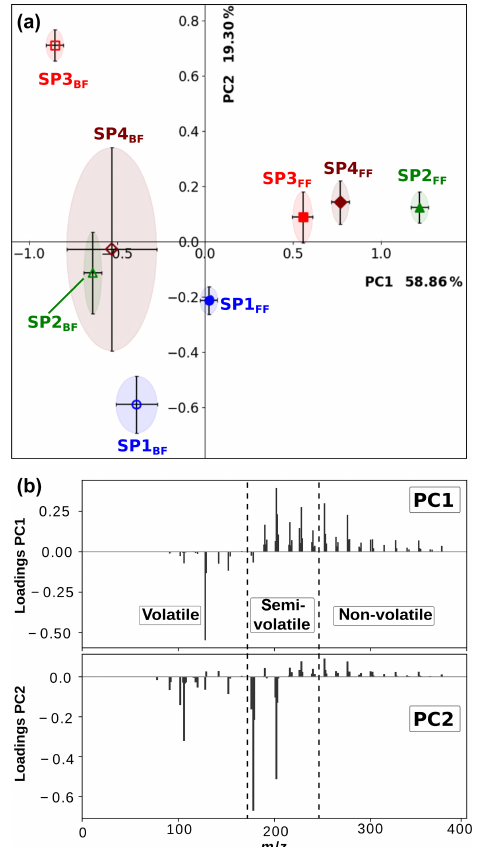
Figure 5. Score (a) and loading (b) plots of PC2 and PC1 derived from principal component analysis of the L2MS data obtained with 266nm